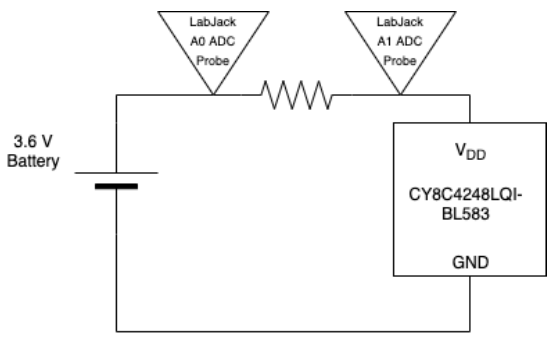
Figure 4. Power measurement setup.